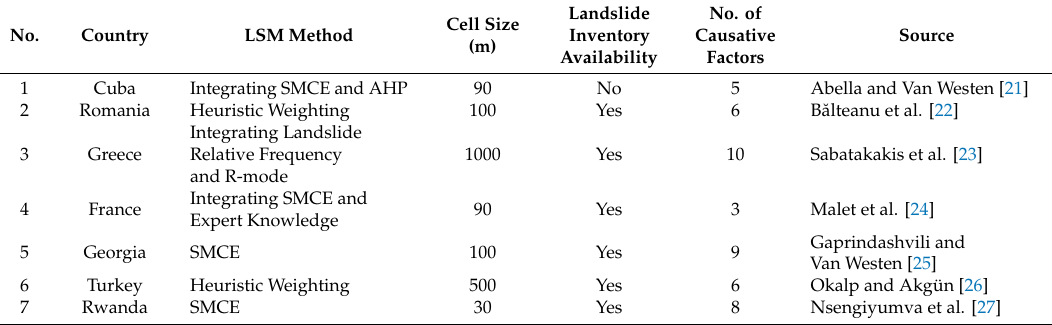
Table 1. Studies of landslide susceptibility mapping at nation scale.